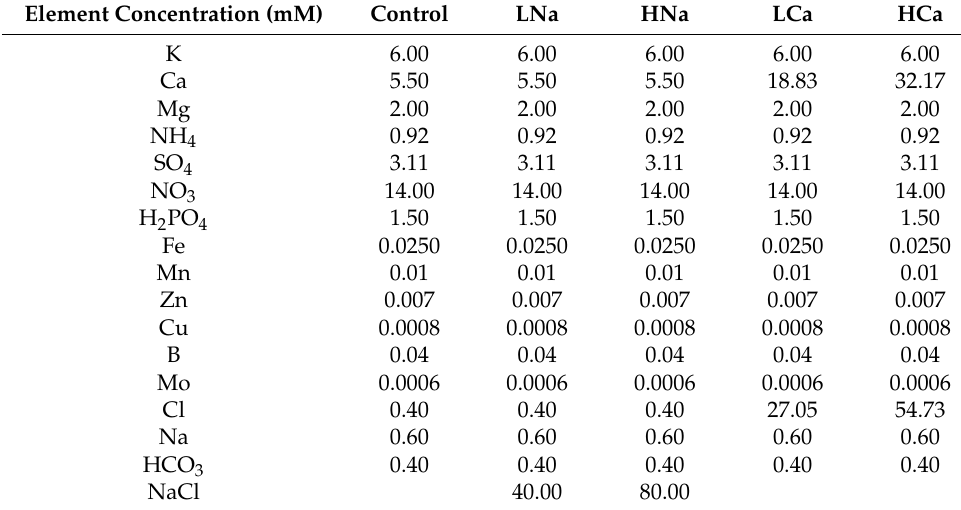
Table 6. Chemical composition of the 5 treatments. All 5 solutions were based on the same control solution and the differences in their chemical composition are caused only by the addition of Ca, Na, and Cl in the form of NaCl and CaCl 2